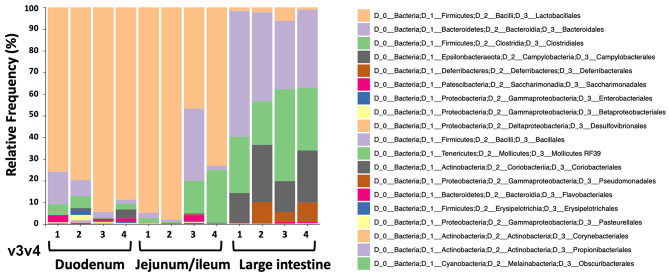
Relative frequencies of bacterial orders in duodenum, jejunum/ileum, and small intestine of hemophilia B mice (n = 4) as determined by bioinformatic analysis of NGS data. The example shown here is for data obtained from amplification of variable region v3v4.